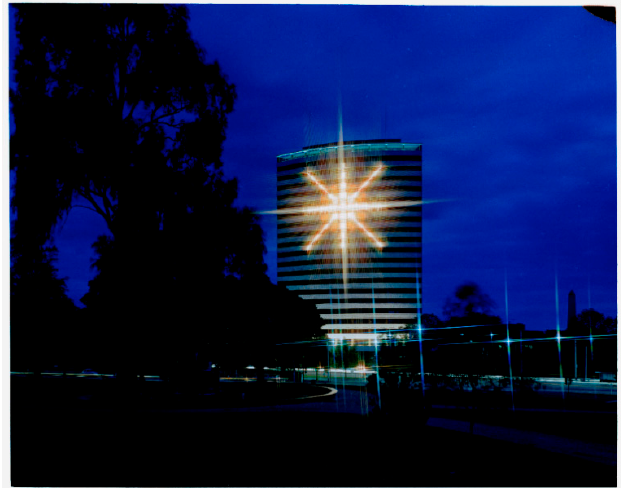
Figure 8. Photograph of a star installed on BP House, St Kilda Rd, Melbourne. We do not know whether it is one of Ostoja’s stars, or not. Mark Strizic, 1976, photograph of the Christmas Star installed on BP House, Melbourne. © the Estate of Mark Strizic. Published with permission. Image courtesy: Pictures Collection, State Library Victoria.